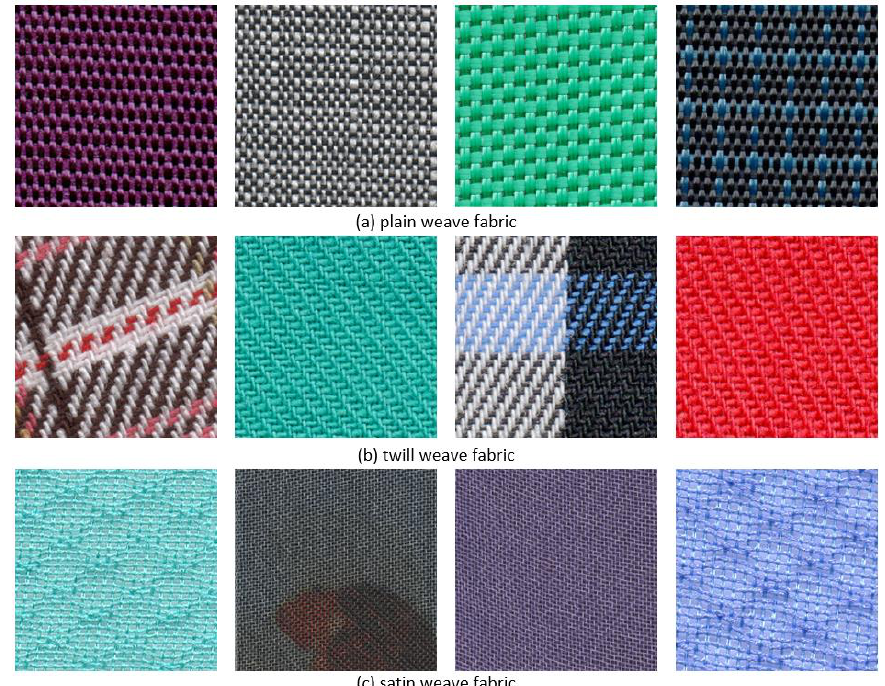
Figure 4. Few samples of woven fabric images from the dataset.